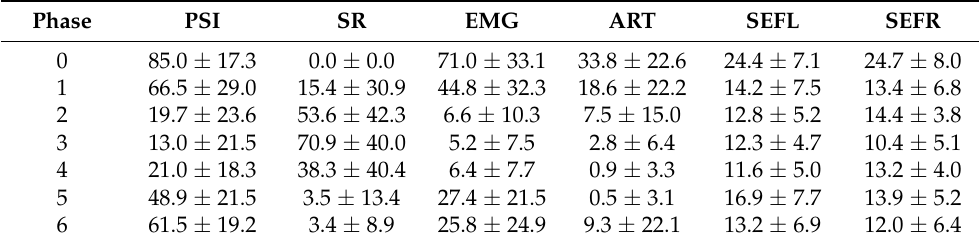
Table 1. Mean ( ± SD) EEG index values of six dogs anesthetized with propofol. Propofol anesthesia was divided into awake (phase 0), graduate induction at 1 mg/kg/min (phase 1), 2.4 mg/kg/min CRI (phase 2), 1.6 mg/kg/min CRI (phase 3), 0.8 mg/kg/min (phase 4), recovery to extubation (phase 5), and recovery to sternal recumbency (Phase 6). The indices were PSI (patient state index), SR (burst suppression ratio), EMG (% of electromyographic activity), ART (% of artifact activity), SEFL, and SEFR (95% of the spectral edge frequency on the left and right hemisphere of the cortex). For statistical significance please see the text. Phase PSI SR EMG ART SEFL